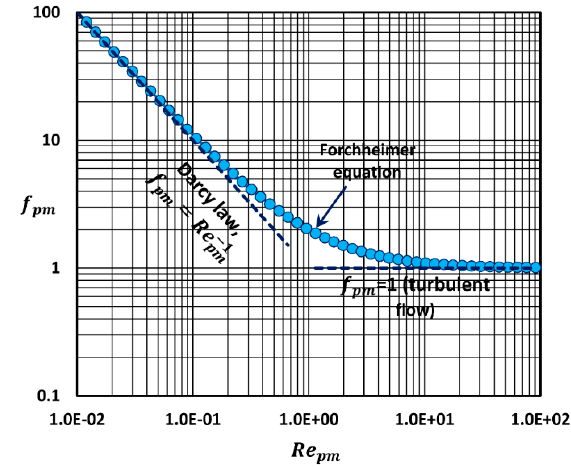
Fluids 2019 , 4 , x 12 of 22 Figure 7. Consolidated porous medium (adapted from www.fotosearch.com.au). Darcy’s law is equally applicable to unconsolidated porous medium such as packed bed of free (un-cemented/un-fused) particles. Thus, the Blake–Kozeny equation or the Carman–Kozeny equation are special cases of the Darcy law. Upon comparison of the Darcy law with Blake–Kozeny/Carman– Kozeny equations, the permeability of a packed bed of uniform size spherical particles can be expressed as follows: (cid:1863) = (cid:1856) (cid:3043)(cid:2870) (cid:2013) (cid:2871) 150(1 − (cid:2013)) (cid:2870) (55) (cid:1863) = (cid:1856) (cid:3043)(cid:2870) (cid:2013) (cid:2871) 180(1 − (cid:2013)) (cid:2870) (56) Equation (55) gives permeability based on the Blake–Kozeny equation whereas Equation (56) gives permeability based on the Carman–Kozeny equation. Darcy’s law is restricted to flows where viscous forces dominate over the inertial forces. At high flow rates, the flow in the porous medium becomes turbulent and Darcy’s law is no longer valid. The pressure-gradient in the turbulent regime is much higher compared with that in the laminar regime at the same superficial velocity (cid:1848) (cid:3046) . In order to extend the Darcy law to turbulent regime, Forchheimer [19] modified the Darcy law by adding a quadratic term as follows: − (cid:1856)(cid:1842) (cid:1856)(cid:1876) = (cid:2020) (cid:1863) (cid:1848) (cid:3046) + (cid:2010)(cid:2025)(cid:1848) (cid:3046)(cid:2870) (57) where the first term on the right side of the equation reflects the viscous effects and the second term reflects the inertial effects. (cid:2010) is called the non-Darcy flow coefficient with a dimension of 1/length. This equation could be re-written in dimensionless form as: (cid:1858) (cid:3043)(cid:3040) = − (cid:1856)(cid:1842) (cid:1856)(cid:1876) (cid:2010)(cid:2025)(cid:1848) (cid:3046)(cid:2870) = 1 + 1 (cid:1844)(cid:1857) (cid:3043)(cid:3040) (58) where (cid:1858) (cid:3043)(cid:3040) is the friction factor for flow in consolidated porous medium and (cid:1844)(cid:1857) (cid:3043)(cid:3040) is the porous- medium Reynolds number, also referred to as Forchheimer number, defined as: (cid:1844)(cid:1857) (cid:3043)(cid:3040) = (cid:2025)(cid:1848) (cid:3046) (cid:2010)(cid:1863) (cid:2020)